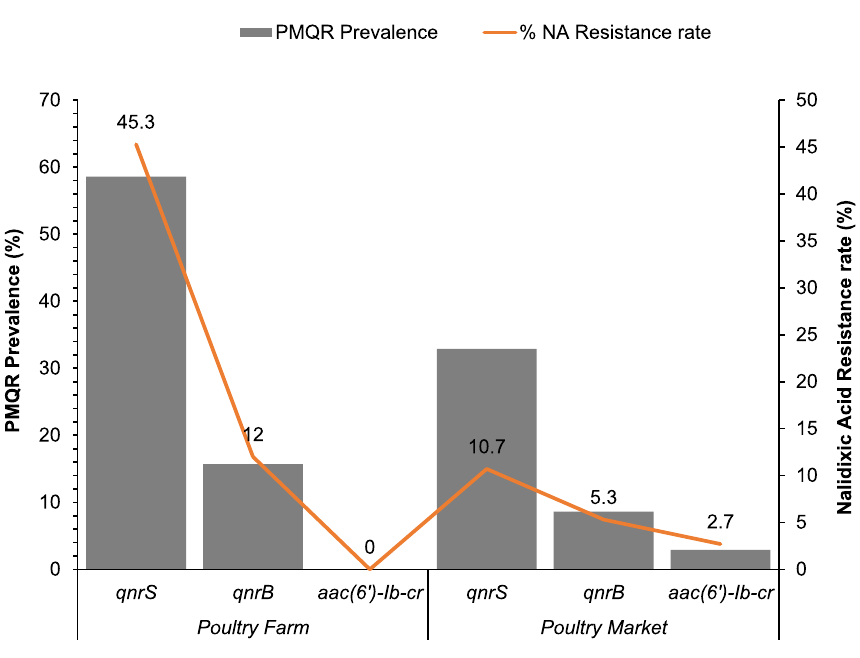
Fig. 2 Distribution of 70 PMQR genes among 75 nalidixic acid-resistant Escherichia coli isolates originating from humans, chickens and poultry farms/ markets. This chart highlights the prevalence of PMQR among nalidixic acid-resistant E. coli isolates from all sample types originating from poultry farms/markets in Abuja, Nigeria, 2019. The prevalence of PMQR is plotted as bars on the primary axis while the nalidixic acid resistance rate in percentage is plotted as a line graph on the secondary axis. The various data points on the line graph are also displayed on the